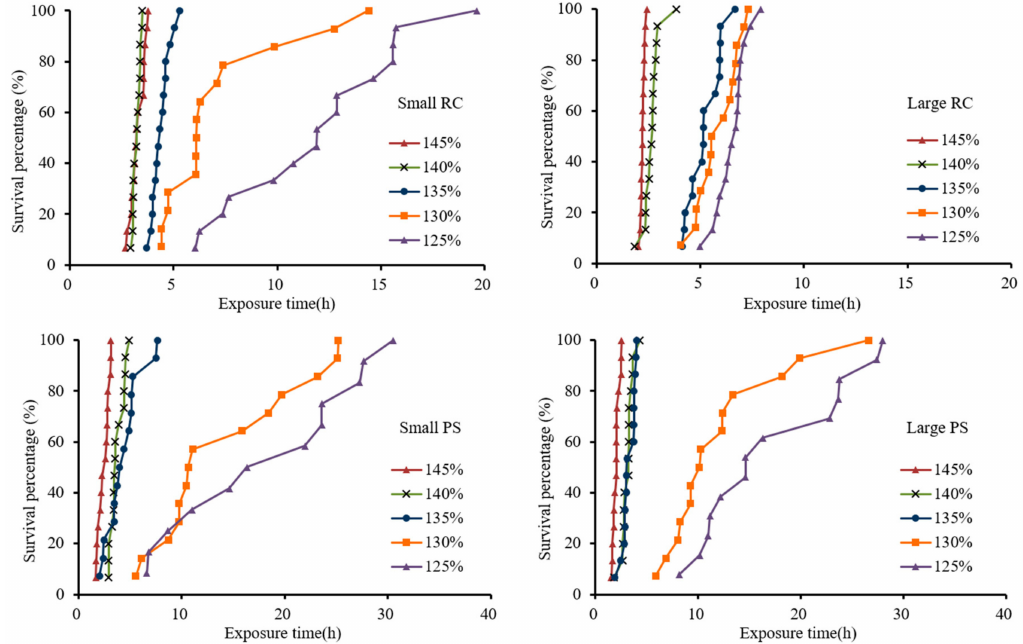
Figure 2. The survival of fish varied with the exposure time at the di ff erent TDG supersaturation levels; RC: Rock Carp; PS: Prenant’s